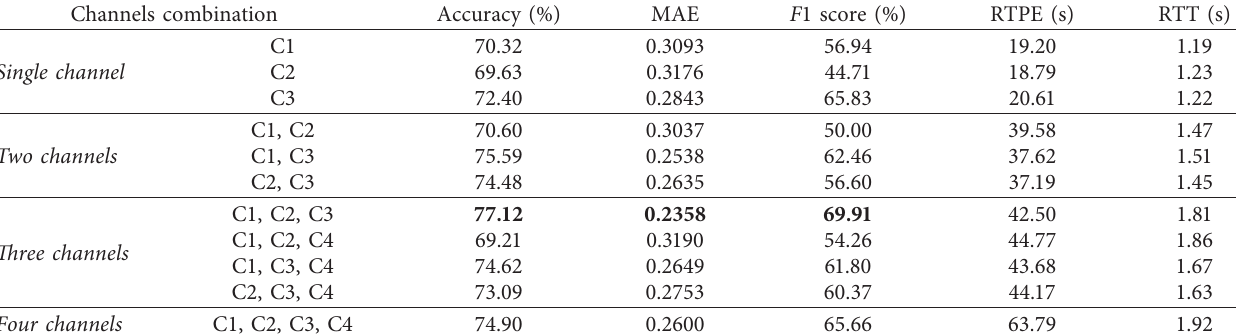
Table 4: Performance of different channels